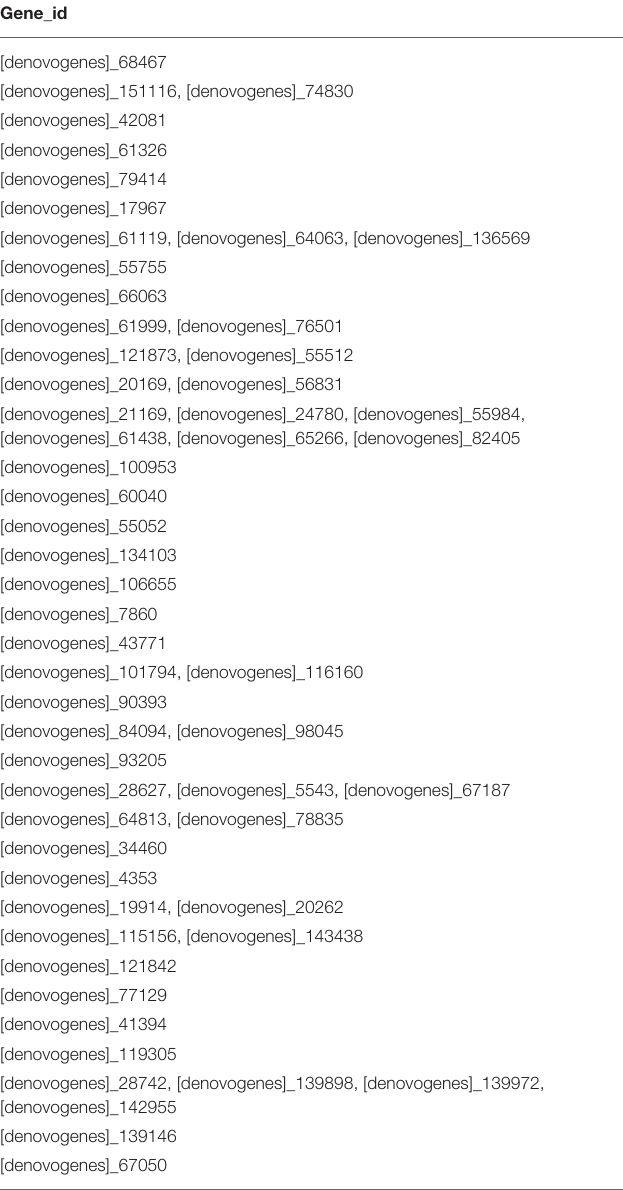
TABLE 5 | Microbe species related to genes of chitin